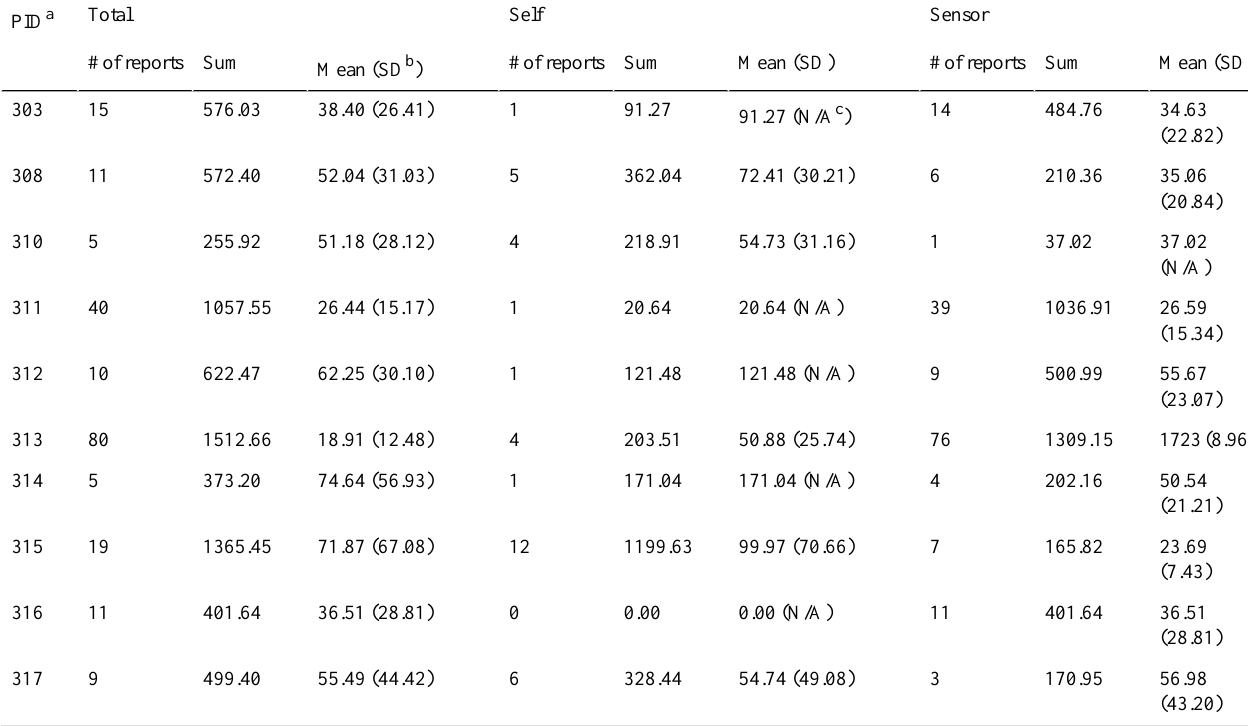
Table 5. Negative valance reports with screen time